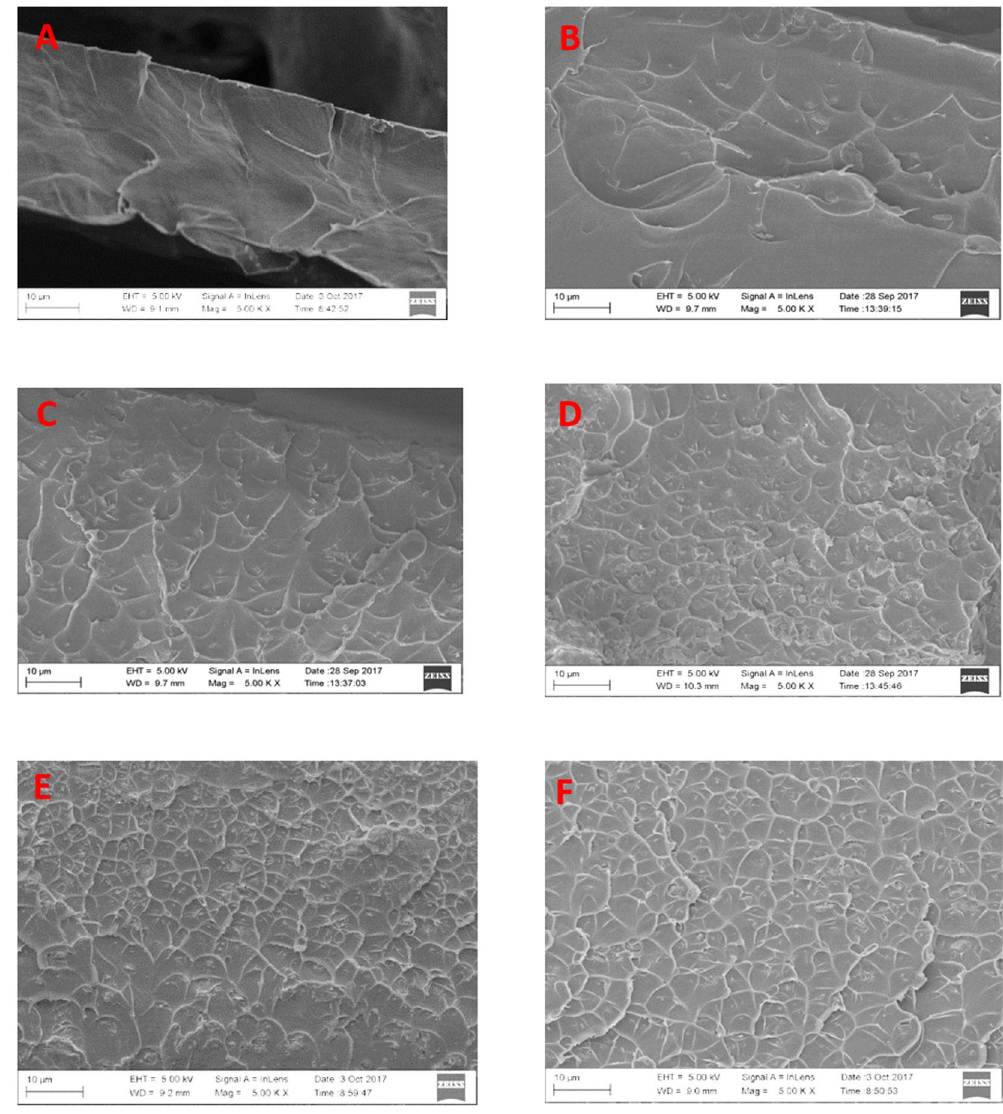
Figure 4. SEM picture of matrimid ( A ), 5 wt% JUC-62-matrimid ( B ), 10 wt% JUC-62-matrimid ( C ), 15 wt% JUC-62-matrimid ( D ), 5 wt% PCN-250-matrimid ( E ) and 10 wt% PCN-250-matrimid ( F